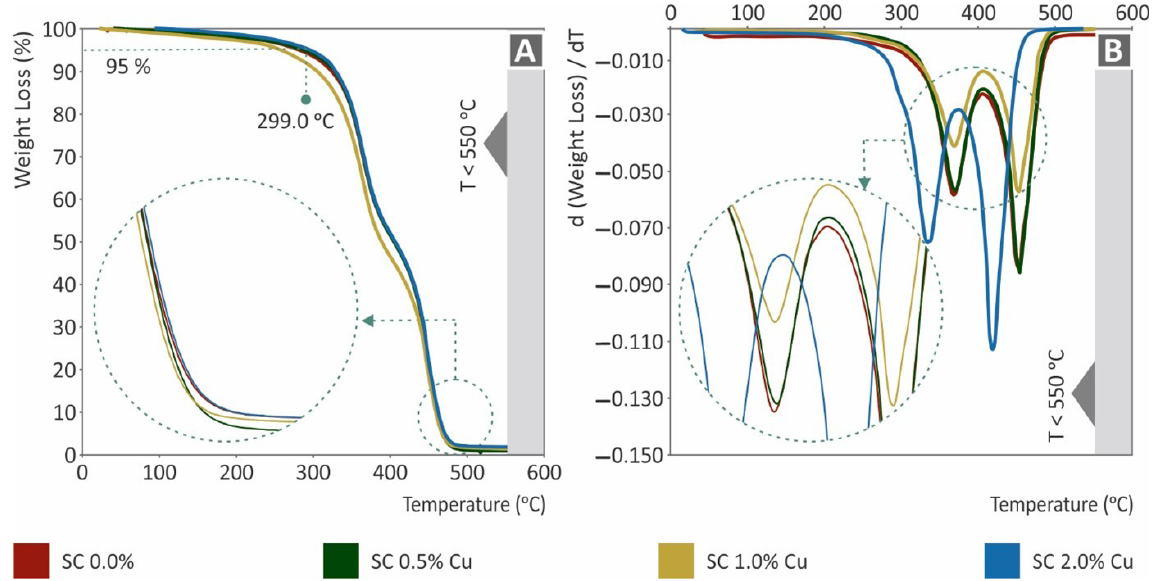
Figure 7. ( a ) Sample’s weight (%) to temperature (°C), ( b ) weight loss rate (mg/mg) to temperature (°C).